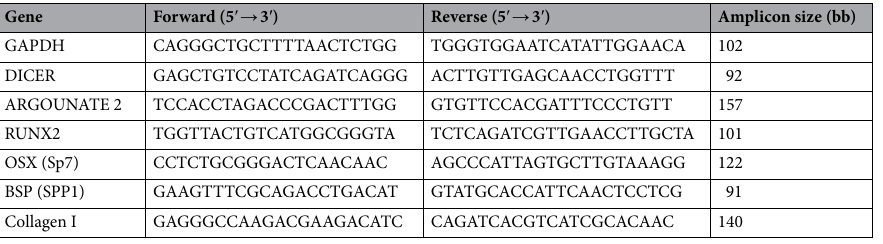
Table 3. Primer sequences used for